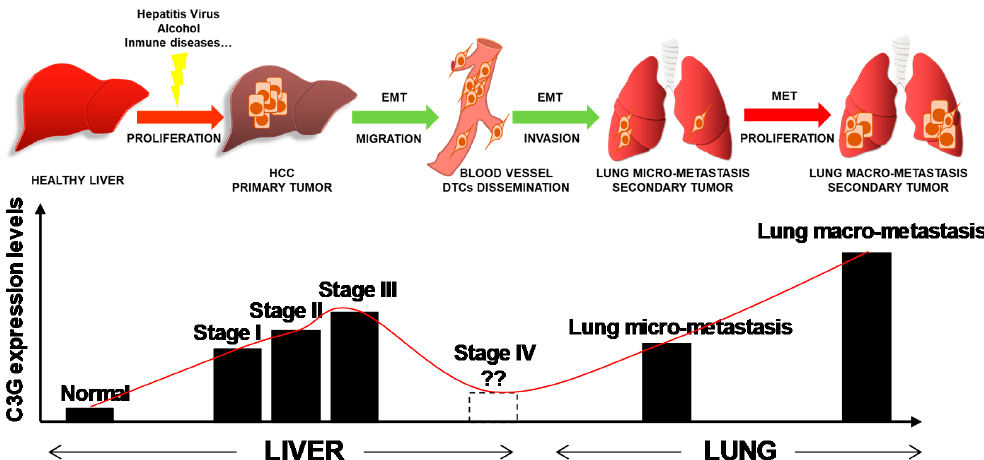
Figure 7. C3G expression from healthy adult liver to HCC tumor growth and progression. Schematic representation of the potential changes in the pattern of C3G expression levels during HCC progression. The progressive increase in C3G would allow HCC primary tumor growth, while a decrease would be associated to EMT and lung metastases generation. Finally, C3G might increase in parallel with lung metastasis growth. Red arrows represent increase and green arrows decrease in C3G